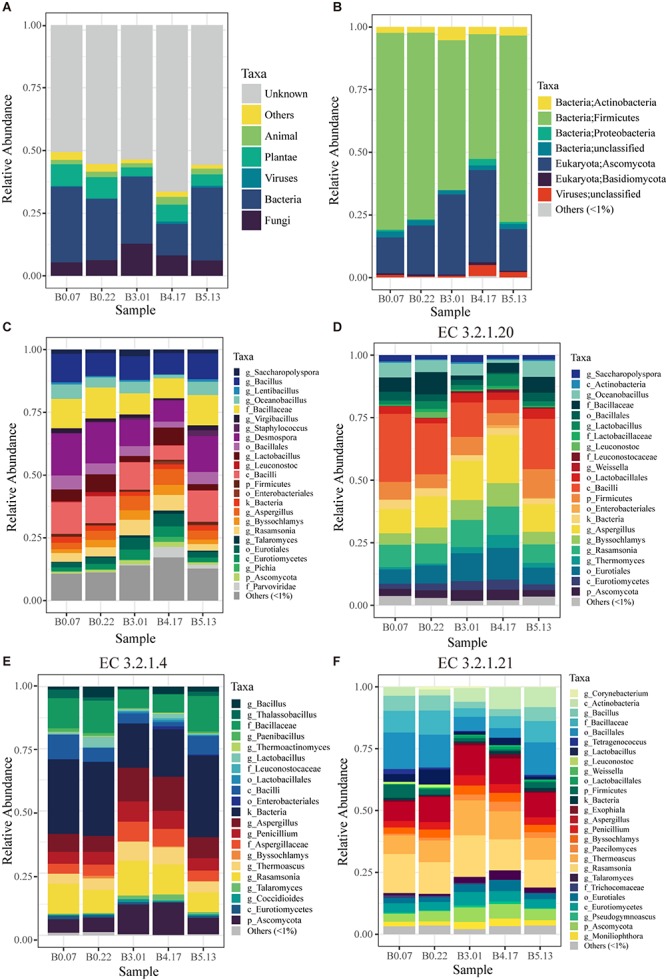
The taxonomic profiles of five mature samples based on metagenomic sequencing. (A) The profile of all data in kingdom level: “Unknown” means having no blast result in “nr” database; “Others” includes unclassified kingdom and protist. (B) The profile of microbial data (archaea, bacteria, fungi, and viruses) in phylum level: “unclassified” includes the data that have no annotation information in phylum level. (C) The profile of microbial data clustered by the lowest common level. (D) The microbial profile of alpha-glucosidase (EC 3.2.1.20) encoding genes grouped by the lowest annotation level. (E,F) The microbial profiles of enzyme encoding genes in cellulose hydrolysis, including endoglucanase (EC 3.2.1.4) and beta-glucosidase (EC 3.2.1.21). “Others (<1%)” includes all the taxonomic groups with relative abundance less than 1%.